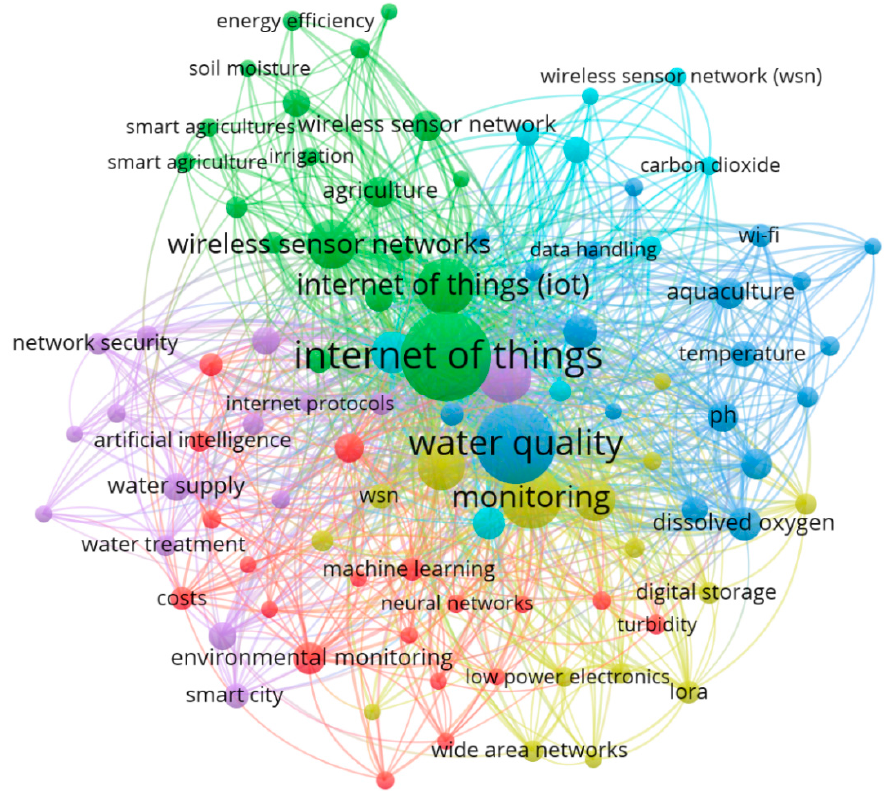
Figure 3. Cluster analysis of the published papers on IoT for water quality monitoring.